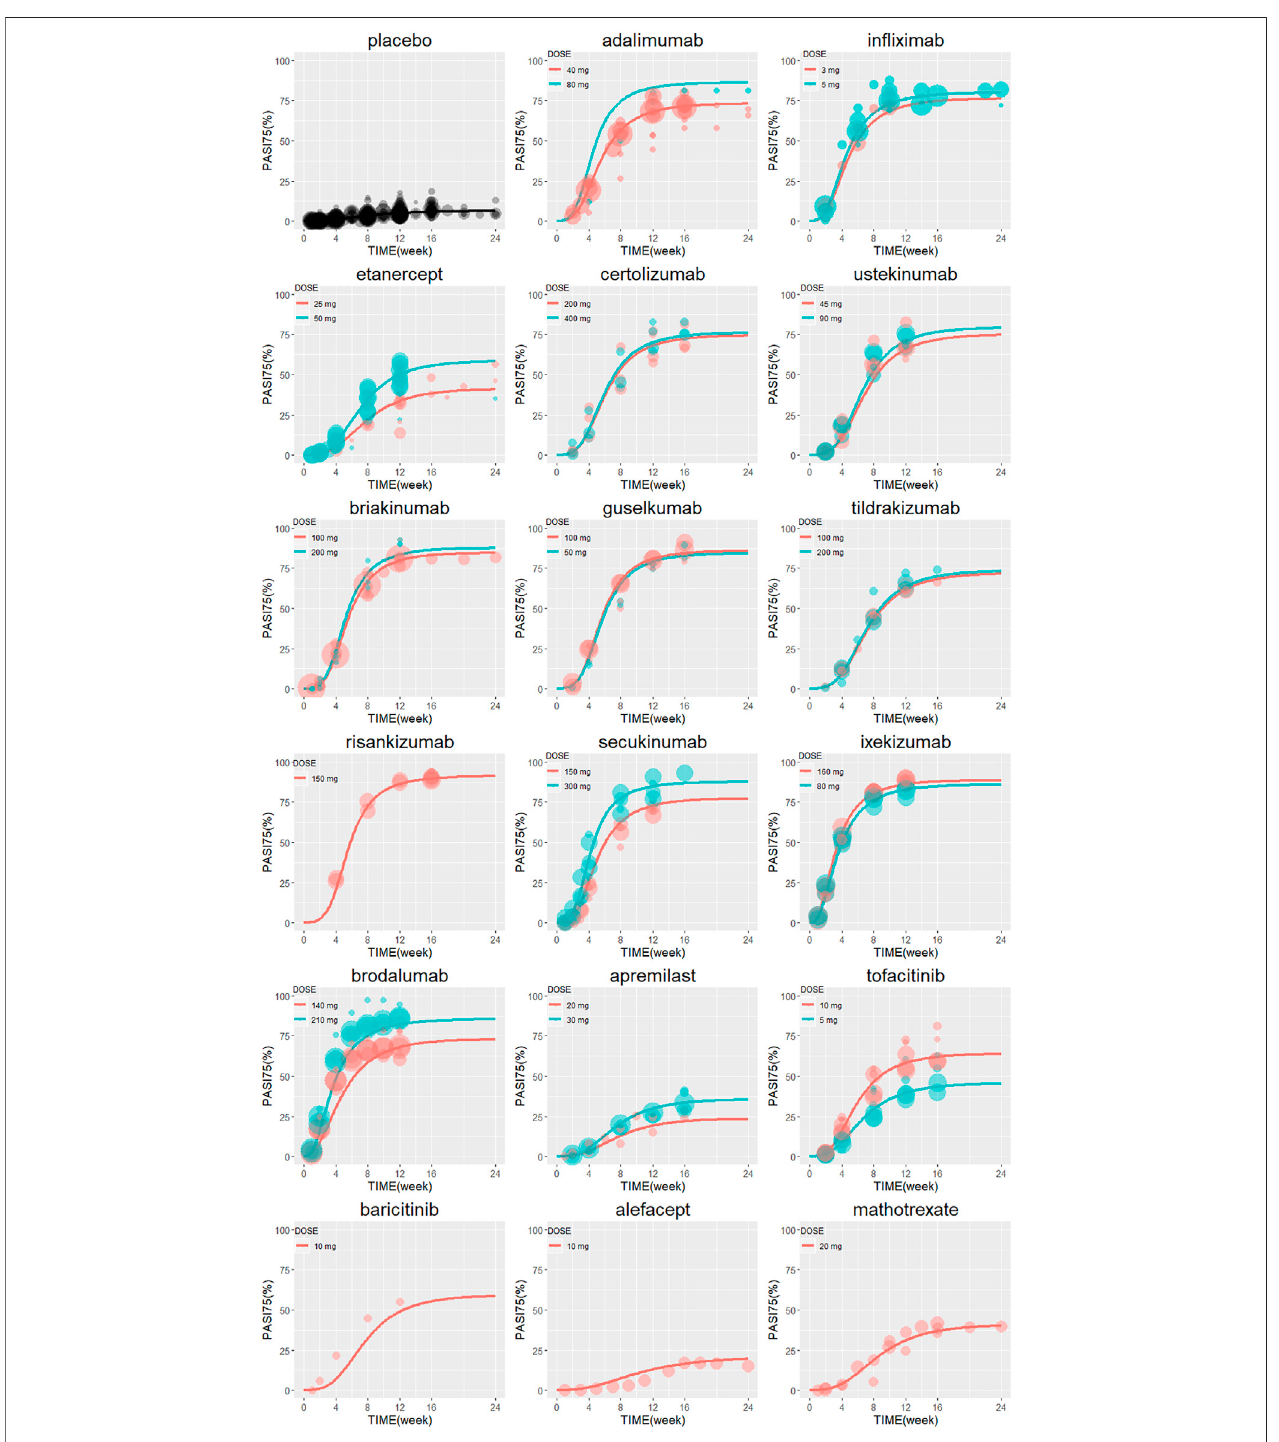
FIGURE 2 | The model predicted typical time course of PASI75 response of each drug. Lines are model predictions for average body weight 90 kg subjects. Circles representtheobservedef fi cacydata,andthesymbolsizeisproportionaltothesamplesize.PASI75, ≥ 75%reductionfrombaselinePsoriasisAreaandSeverityIndexscore.